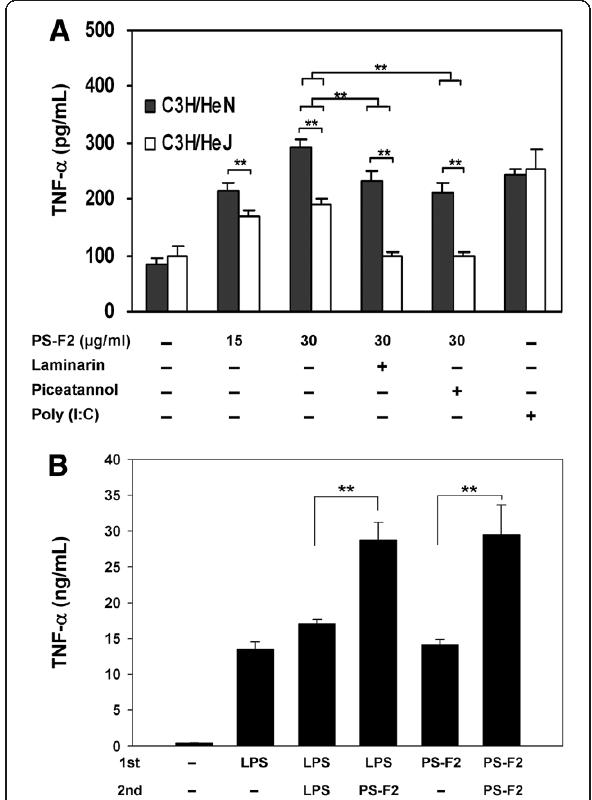
Figure 2 The role of TLR4 in PS-F2-induced macrophage activation. ( A ) BMDMs from C3H/HeN (wild type) and C3H/HeJ (TLR4 mutant) mice were pre-incubated with or without